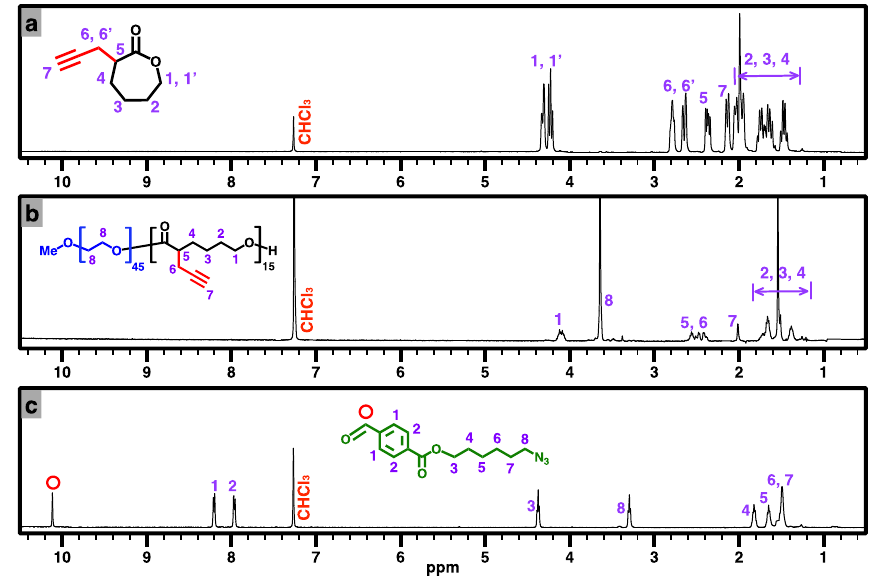
Figure 2. 500 MHz 1 H NMR spectra: ( a ) alkyne-functionalized ε-caprolactone (CL) ( 1 ), ( b ) alkyne- functionalized poly(ethylene glycol)- b -poly(ε-caprolactone) (PEG- b -PCL) ( 2 ), and ( c ) 6-azidohexyl 4- formylbenzoate pH-responsive spacer molecule ( 3 ) in CDCl 3